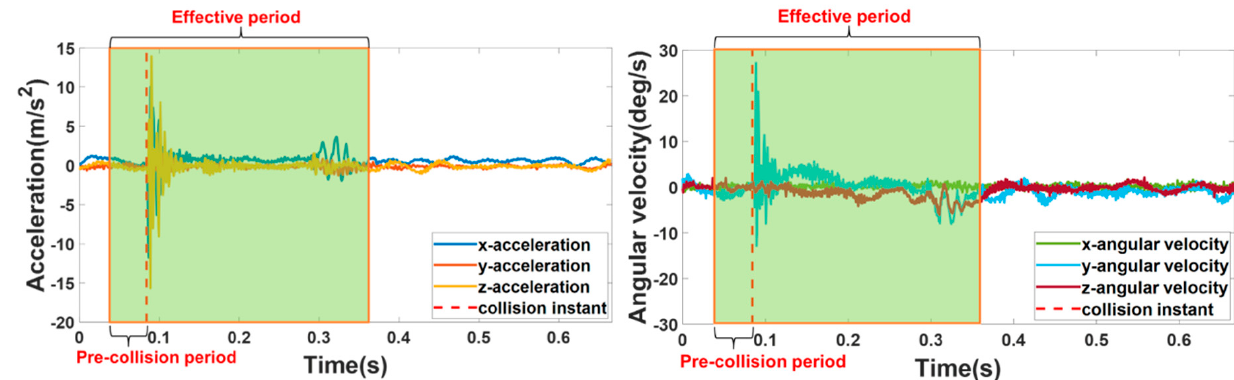
Figure 2. The waveform of a collision point.